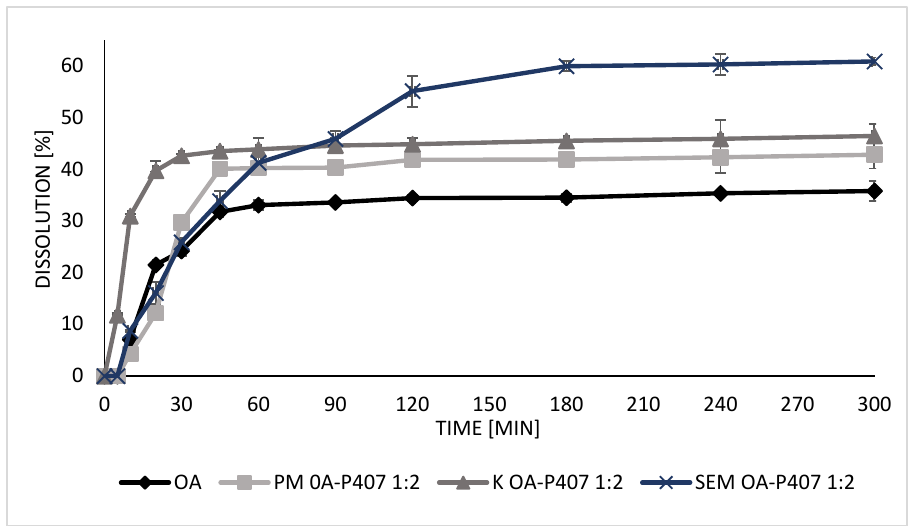
Figure 6. Dissolution profiles of OA, PM OA-P407 1:2, K OA-P407 1:2, and SEM OA-P407 1:2.